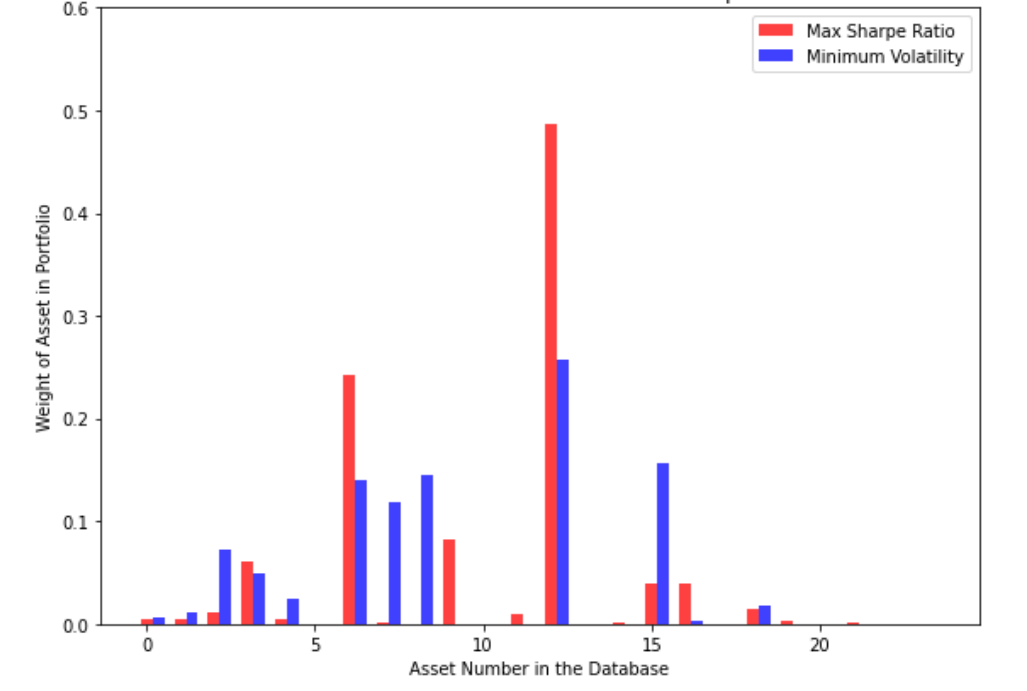
Figure 24. Alternative portfolio optimization: Weights and Sharpe